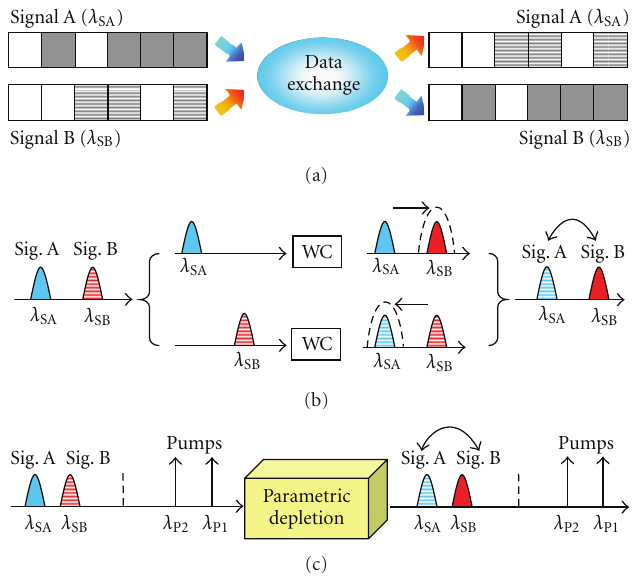
Figure 2: (a) Concept of data exchange in the wavelength domain (wavelength interchange/exchange). (b) Data exchange by two separate wavelength converters. (c) An example of data exchange by signal depletion and wavelength conversion in a single nonlinear